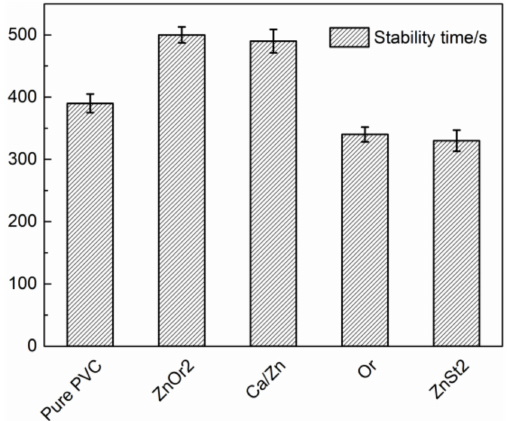
Figure 3. The effects of thermal stability time for poly(vinyl chloride) (PVC) with different kinds of thermal stabilizers at 180 ◦